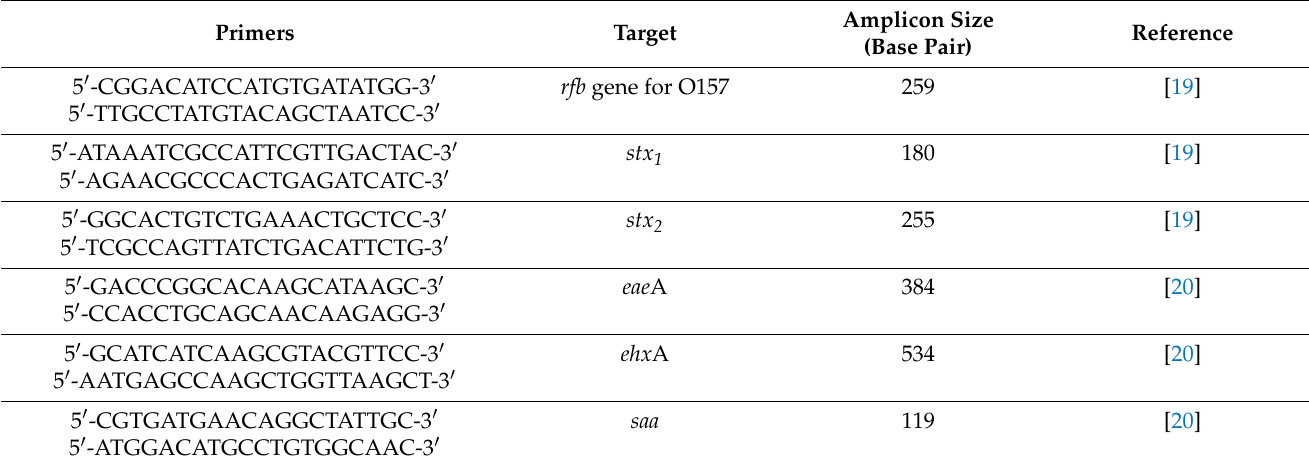
Table 1. Primer pairs used for the PCR reaction.